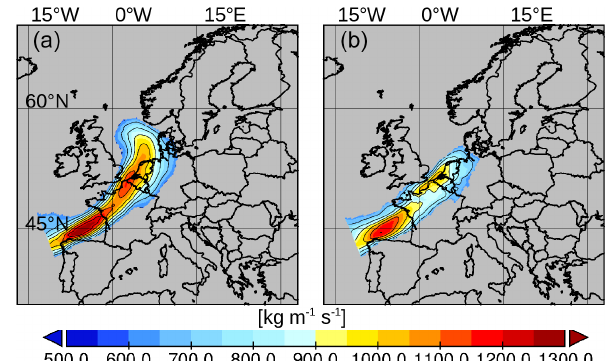
Figure 3. AR associated with storm Lothar, detected in the ERAI reanalysis (a) and in the ERAI hindcast simulation (b) , 25 Decem- ber 1999; 00:00:00UTC. IVT values below the AR 85th percentile are masked